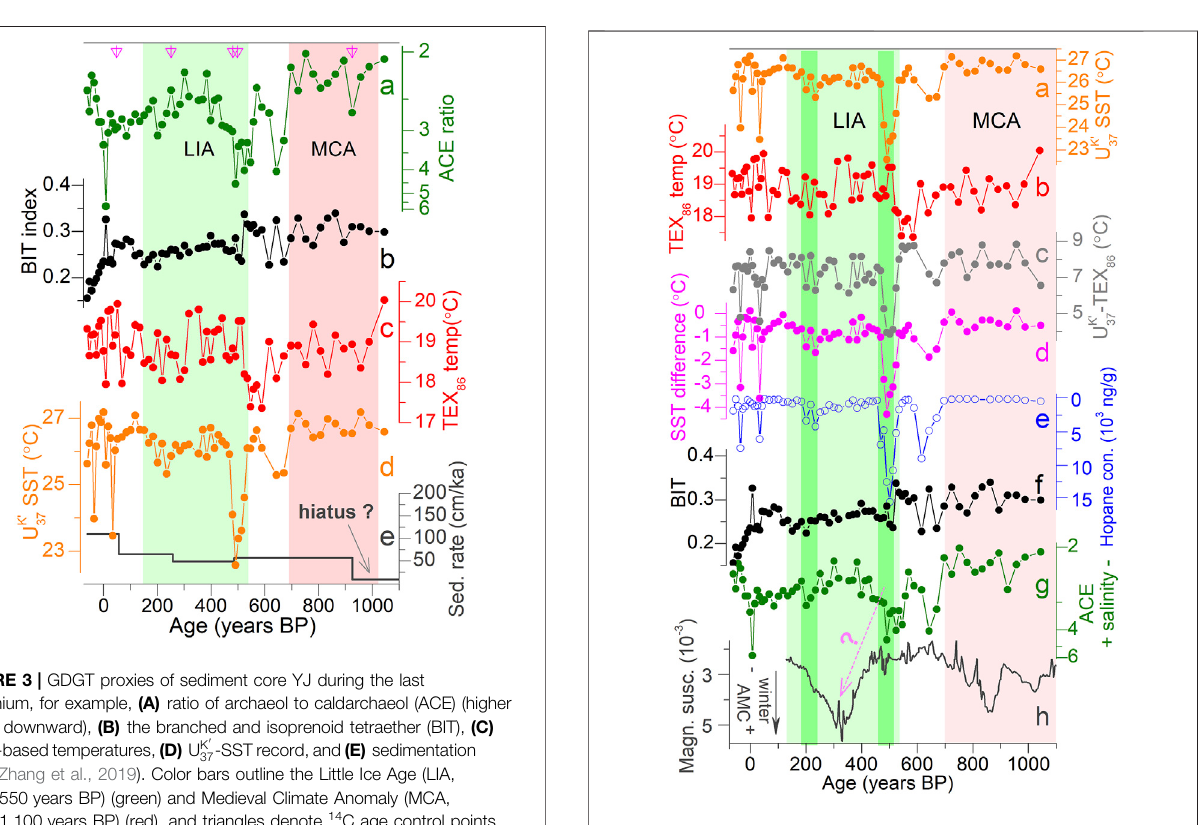
FIGURE 4 | Organic geochemical proxies of core YJ over the last millennium, including (A) U K ′ 37 -SST record (Zhang et al., 2019), (B) TEX 86 -based temperature, (C) vertical thermal gradient at site YJ (U K ′ 37 − TEX 86 values), (D) U K ′ 37 -SST difference between two sites YJ and NS02G (YJ minus NS02G), (E) hopane compounds (Zhang et al., 2019), (F) the branched and isoprenoid tetraether (BIT), and (G) the ratio of archaeol to caldarchaeol (ACE). Note that magnetic susceptibility at Lake Huguangyan Maar (higher values downward, Yancheva et al., 2007) is also plotted (H) for comparison (with a possible shift of their peaks due to the age uncertainty). Color bars mark the same intervals as in Figure 3 (two cold epochs within the LIA, e.g., ∼ 250 years BP and ∼ 500 years BP, are further